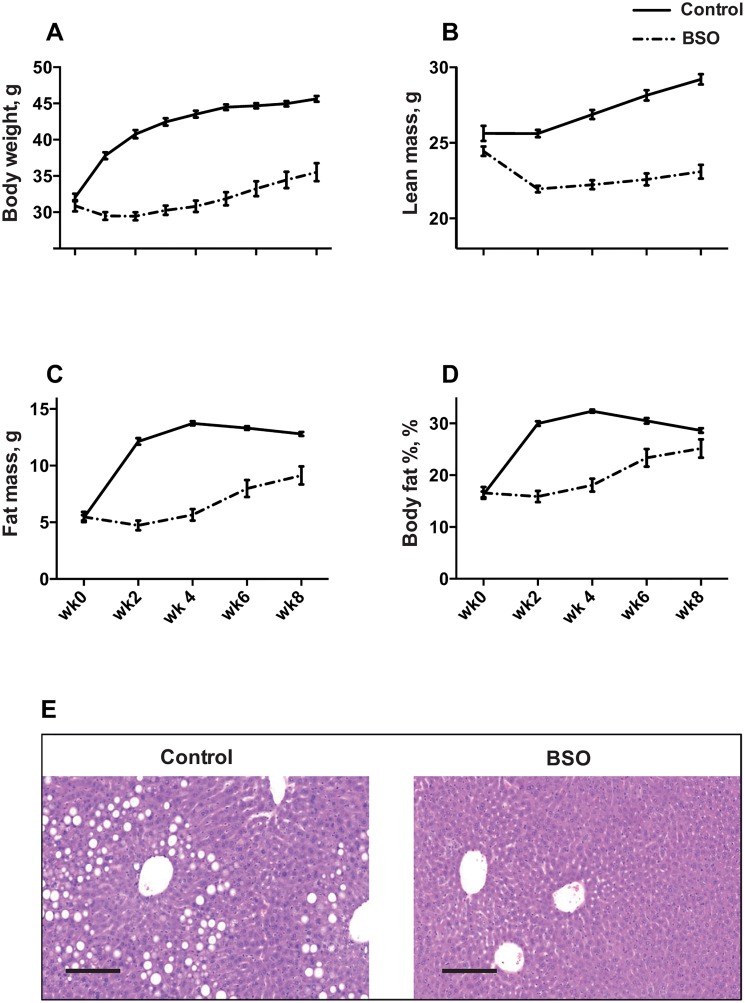
Effect of BSO on body composition.A-D Body weight and body composition in BSO-treated and control mice at the start of BSO treatment (wk-0) and every two weeks till termination 8 weeks later (wk-8). Data represents mean ± SEM from N = 20 (BSO) and N = 24 (controls). Depicted P values are from repeated measures ANOVA. E Photomicrograph of liver sections stained with H&E, showing hepatoceullar vacuolation in control mice and absence of vacuolation in BSO mice. Scale bar represents 300 μm.